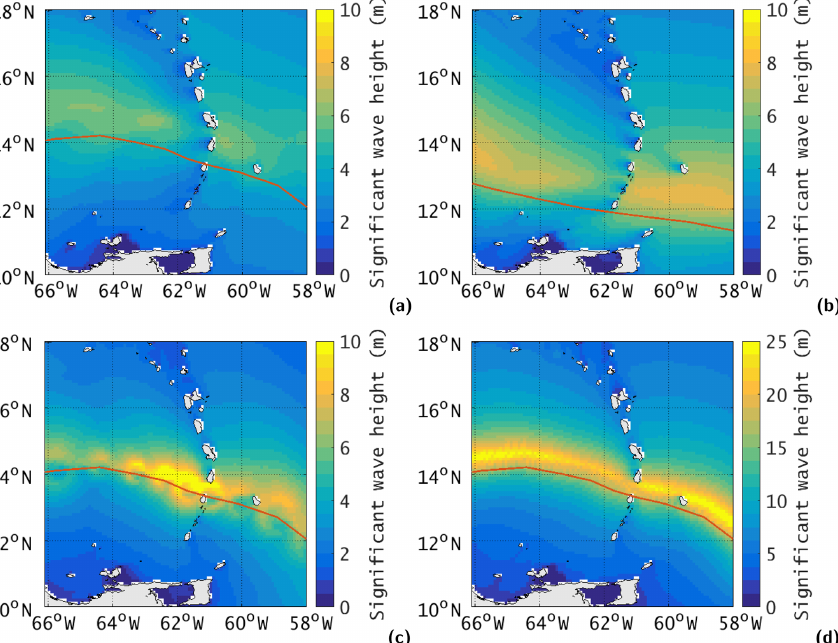
Figure 7. Maximum significant wave height simulated by the WW3 Caribbean model during (a) Hurricane Tomas (2010) and (b) Hurricane Ivan (2004) forced by ERA5, (c) Hurricane Tomas (2010) forced by the Holland model parametric wind field, and (d) Hurricane Tomas (2010) forced by the enhanced wind field.